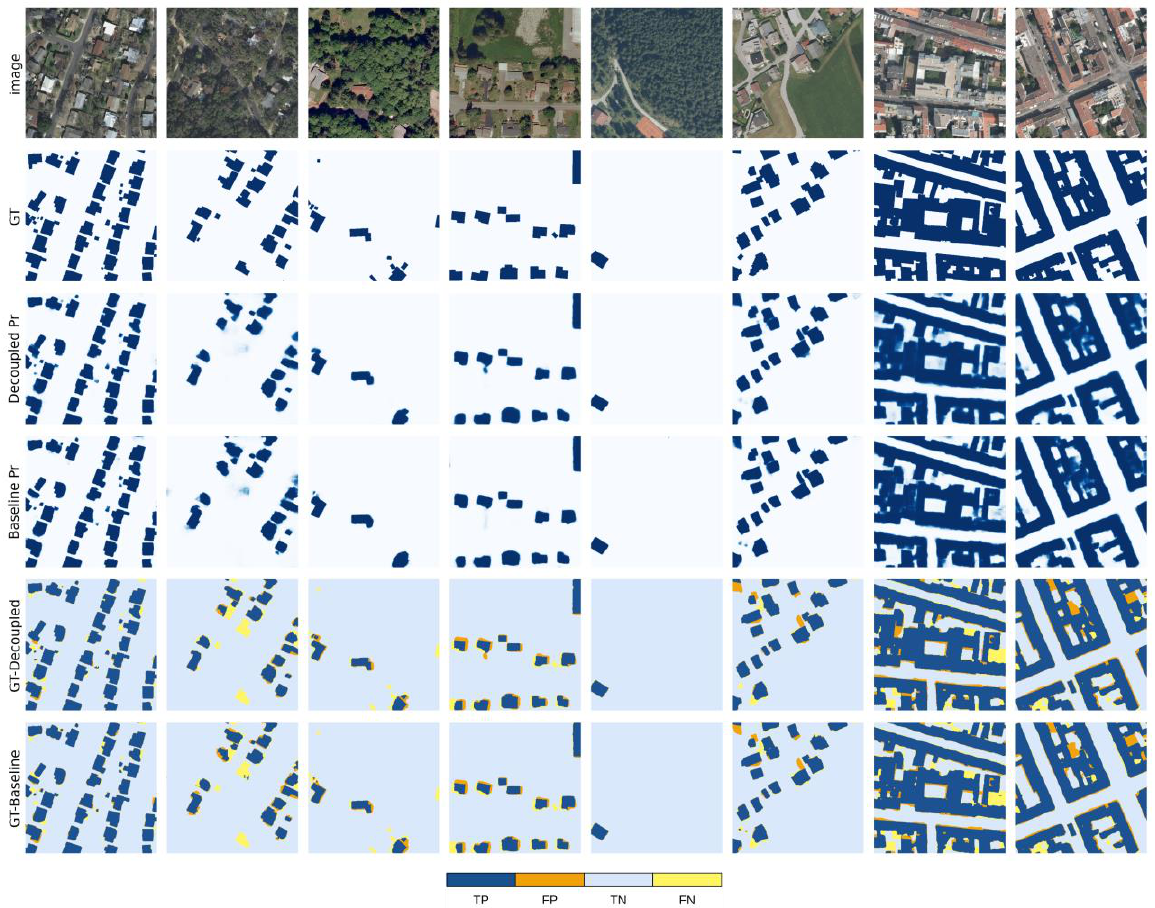
Figure 7. Comparison between the predicted results and the ground truth data on random image